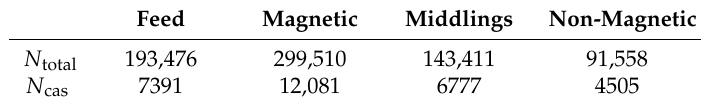
Table 6. Number of particles ( N total : all particles; N Cas : particles containing cassiterite). Feed Magnetic Middlings Feed